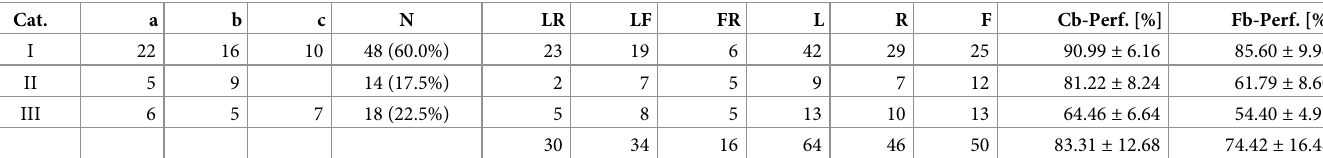
These are the BCI experiment results and provide the statistics on the BCI performance of the general population, never published before with such accuracy on a large dataset. It can be seen that 60% of the users achieved BCI control (Cat. I) with an average perfor- mance of 85%, 17.5% showed SMR modulation in calibration but failed in achieving BCI con- trol in the MI-Fb session (Cat. II) and 22.5% did not exhibit an SMR modulation strong enough to calculate stable CSP filters already in the MI-Cb session (Cat. III). Note that just 7 participants, i.e. 8.75%, did not exhibit any, or almost any, idle SMR rhythm. It can be also observed that most of the good performing users (actually all users of Cat. Ia except for 4) used the combination Left/Right hand. In fact, the use of the class Foot comes into play just when the desynchronization between left and right hemisphere results difficult. Actu- ally, among Cat. II and III, most participants showed prevalence either for Left/Foot or for Foot/Right . Another evidence is that the class combination Left/Foot was also in general selected in comparison to Foot/Right , so that Left is the most often occurring class.